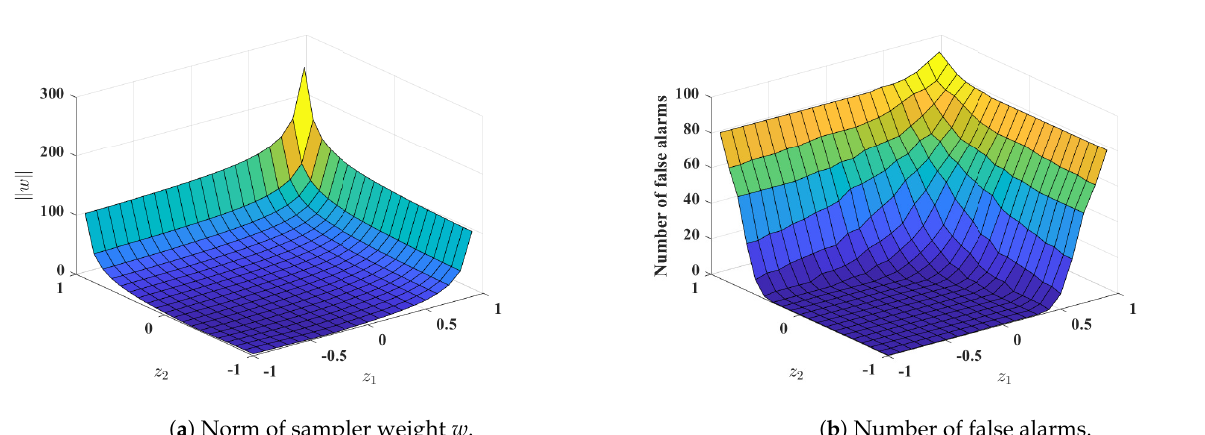
Figure 12. Effect of the location of desired zeros on the size of sampler weight and the number of false